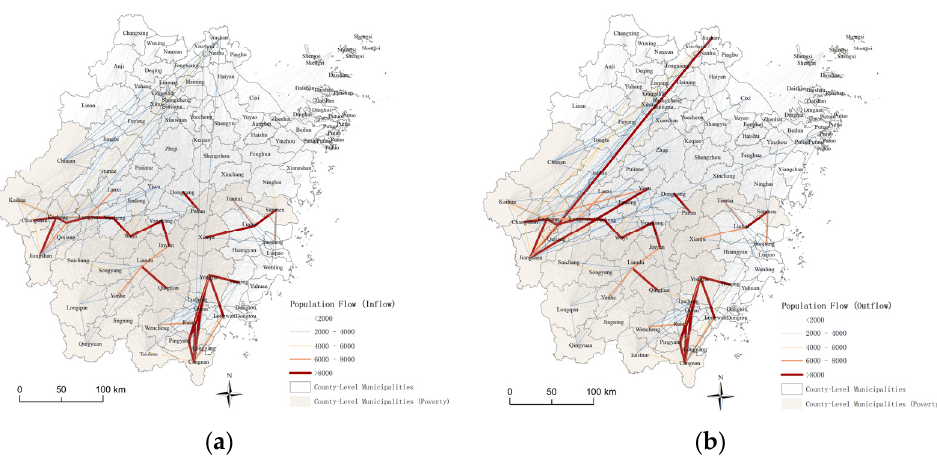
Figure 4. The interjurisdictional population flow for poverty counties in Zhejiang province, China: ( a ) population inflow; ( b ) population outflow.